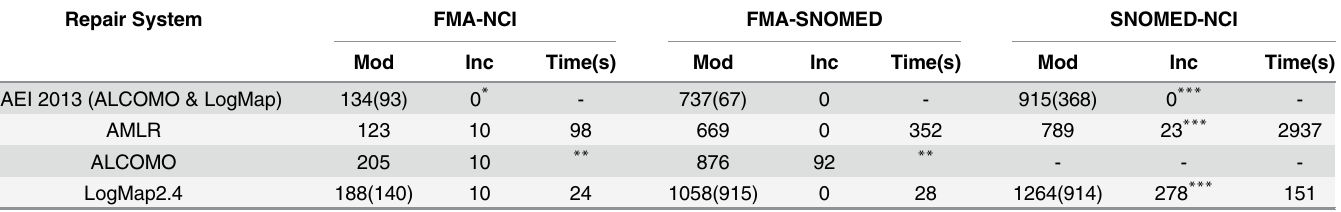
Table 4. Evaluation of the repairs produced for the UMLS-based alignments from the OAEI 2013 Large Biomedical Ontologies track. Mod denotes the total number of modifications to the alignment (with removed mappings shown in parentheses when systems also alter mapping relations) and Inc denotes the number of incoherent